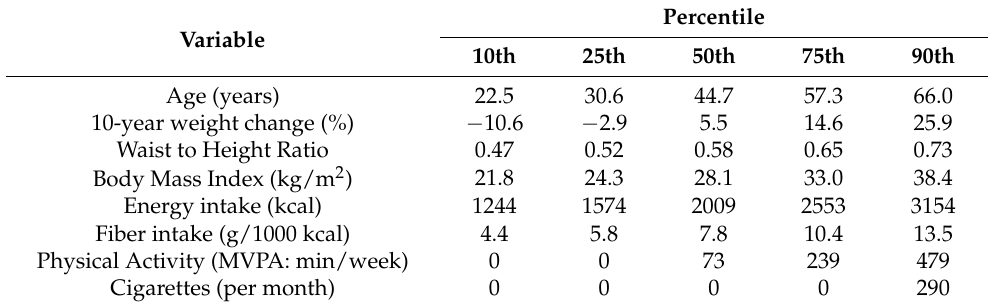
Table 1. Percentile distributions of the key continuous variables representing U.S. adults (n = 15,185). Variable